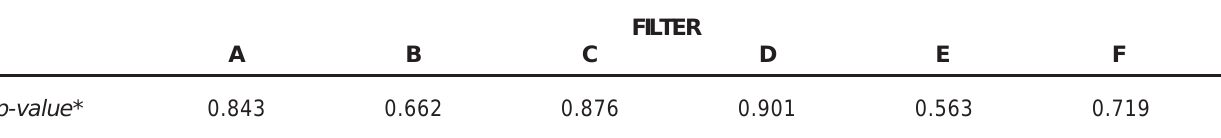
TABLE 4- p-value of the comparisons among the values of the examiners using the same